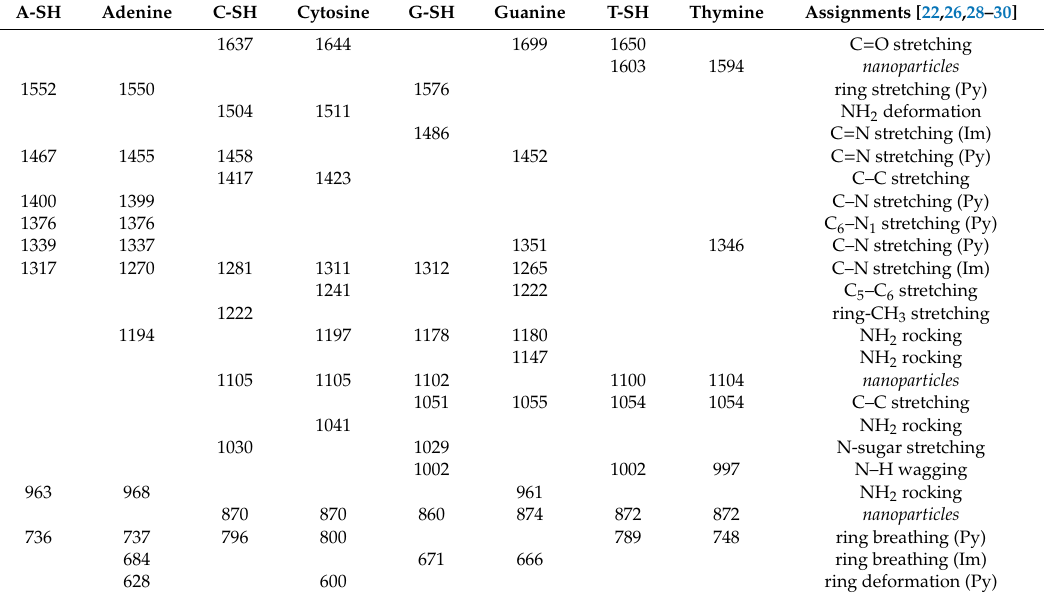
Table 1. Assignments of the most intensive Raman bands appearing in the SERS spectra of adenine, cytosine, guanine and thymine and their respective thiolated mononucleotides. The most intensive background bands of gold sols are also